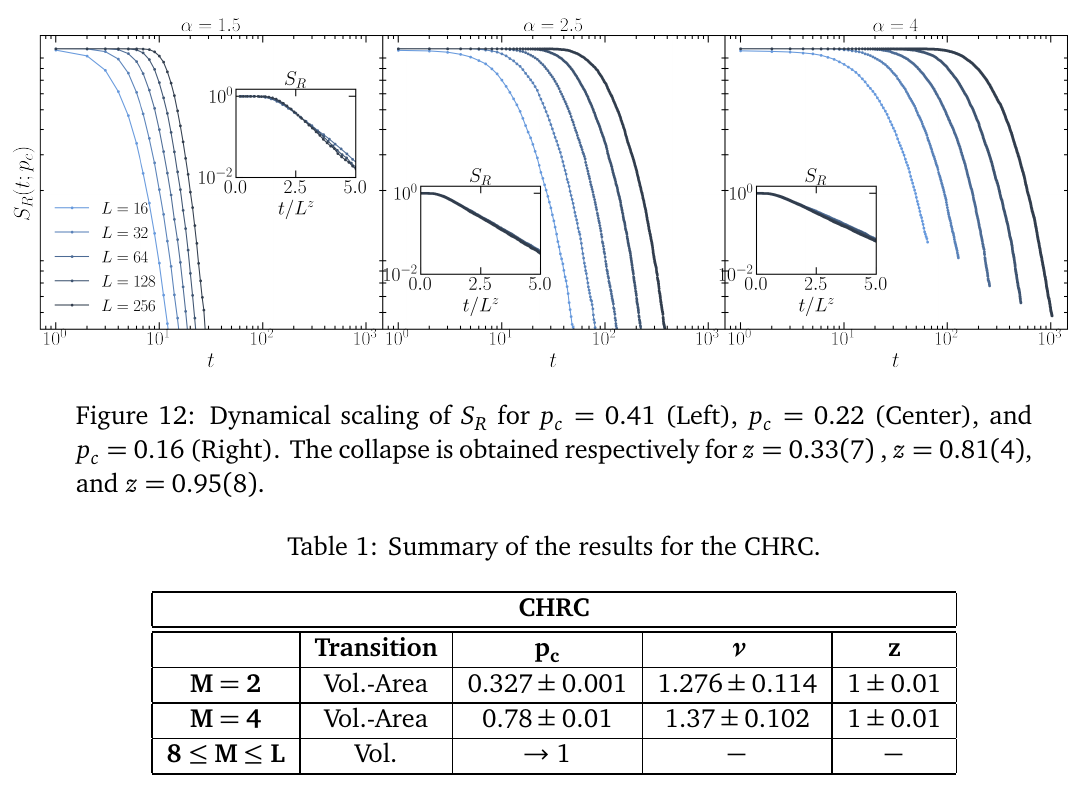
Table 2: Summary of the results for the